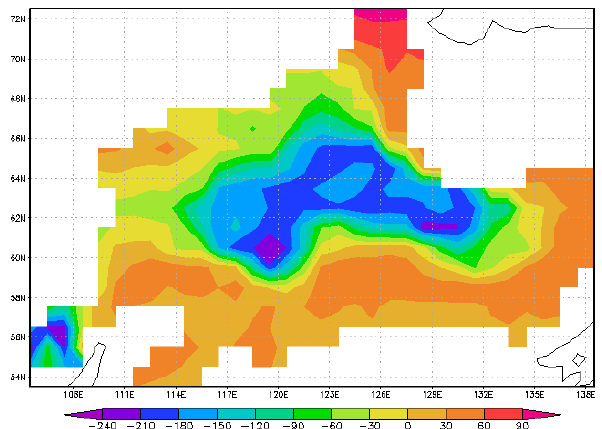
Fig. 6. Total soil moisture comparison over the Lena basin between CTRL and NEW. The average difference in total soil moisture over the decade 1989–1999 between the NEW and CTRL models.